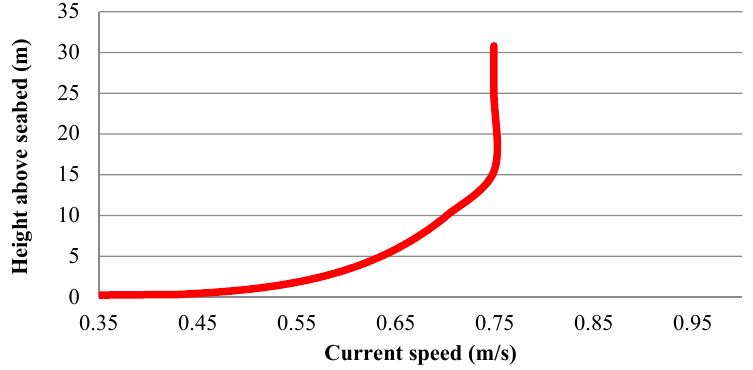
Figure 3. Flow velocity profile along the height above seabed.